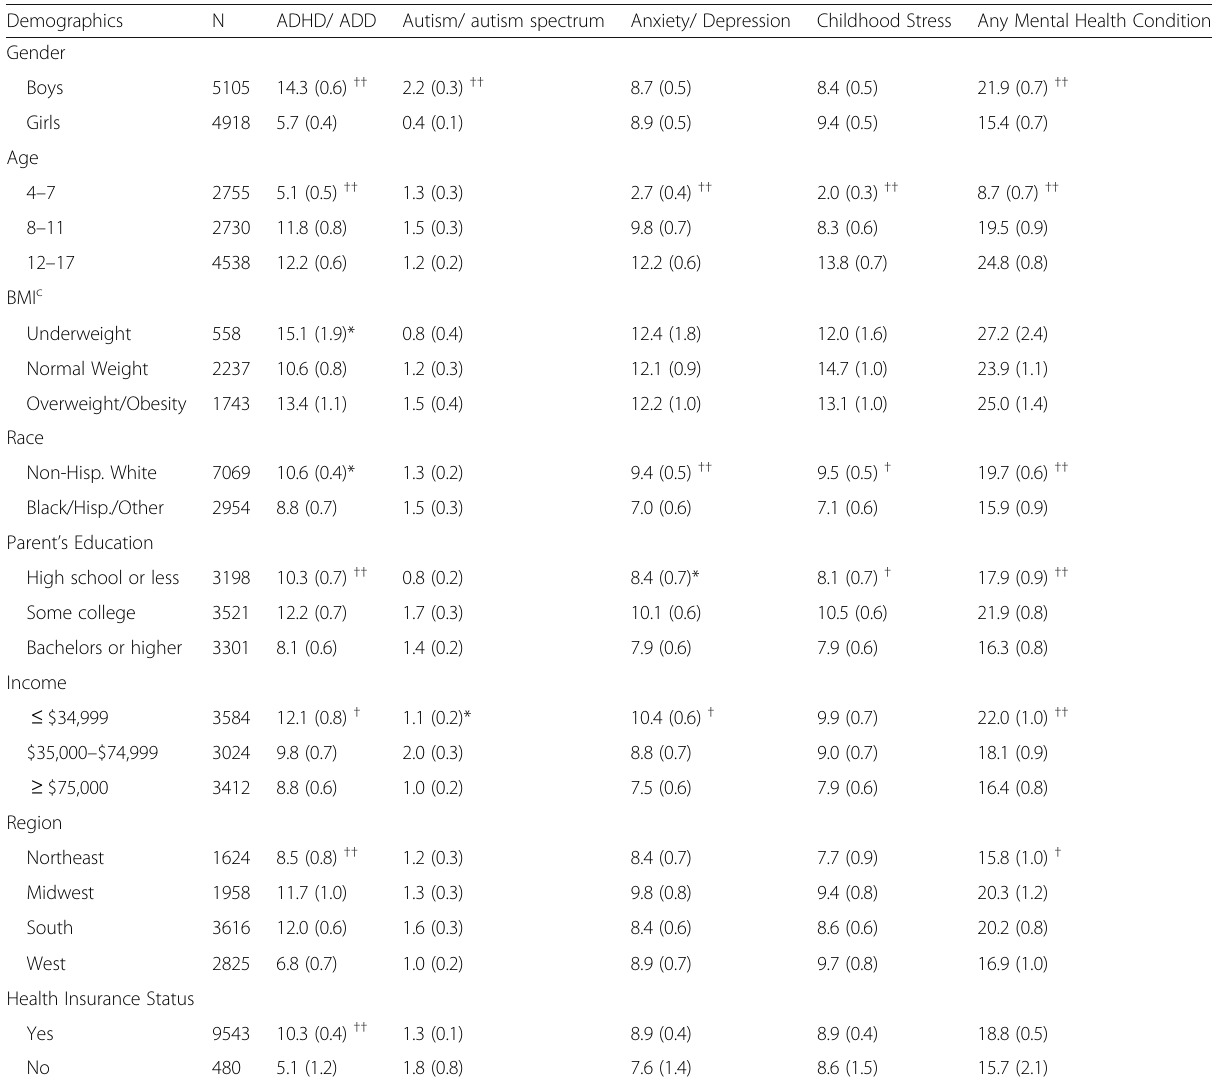
Table 1 Percentage of children in demographic subgroups a (standard error) with mental health condition b for the association of the demographic characteristic with the condition Demographics N ADHD/ ADD Autism/ autism spectrum Anxiety/ Depression Childhood